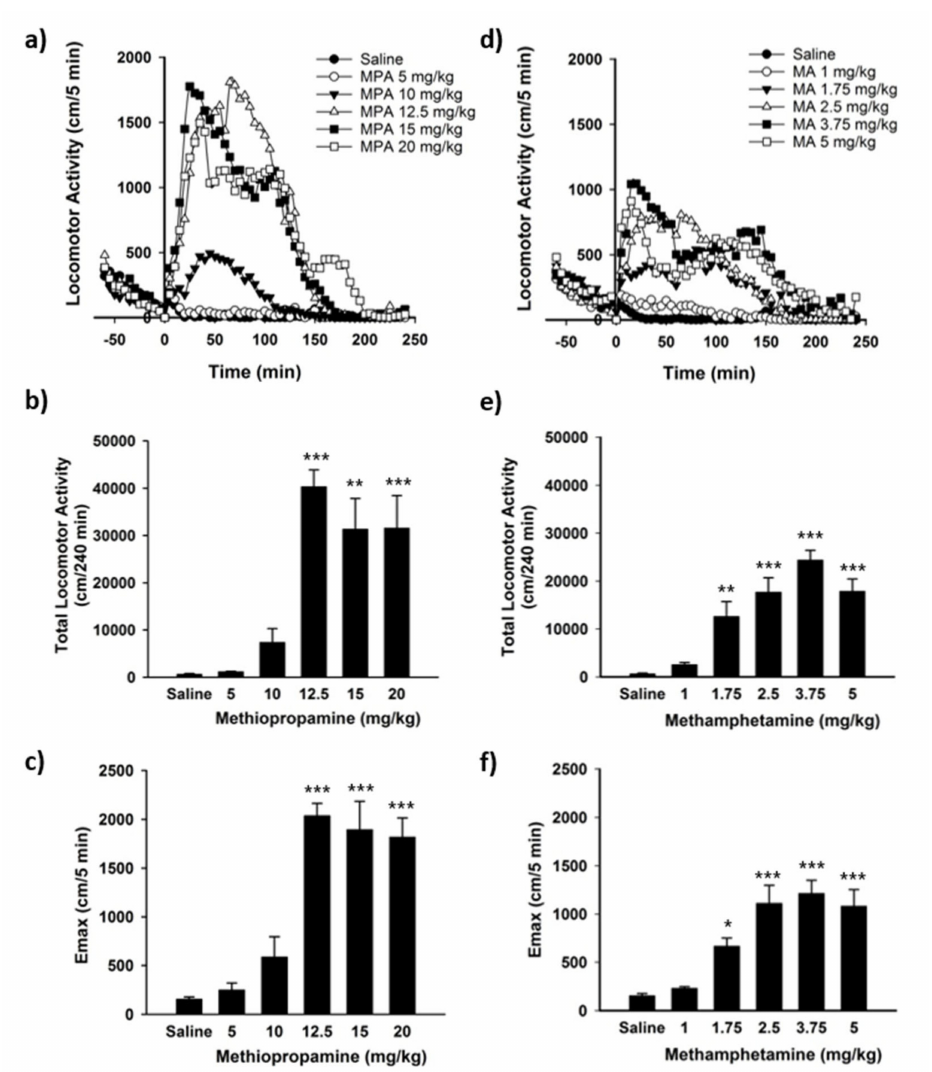
injection of 12.5 mg/kg. The locomotor activity reached a “plateau effect” at 12.5 mg/kg, with no further increases in the total run distance or E max following administration of higher 15 and 20 mg/kg doses (Figure 2b,c).